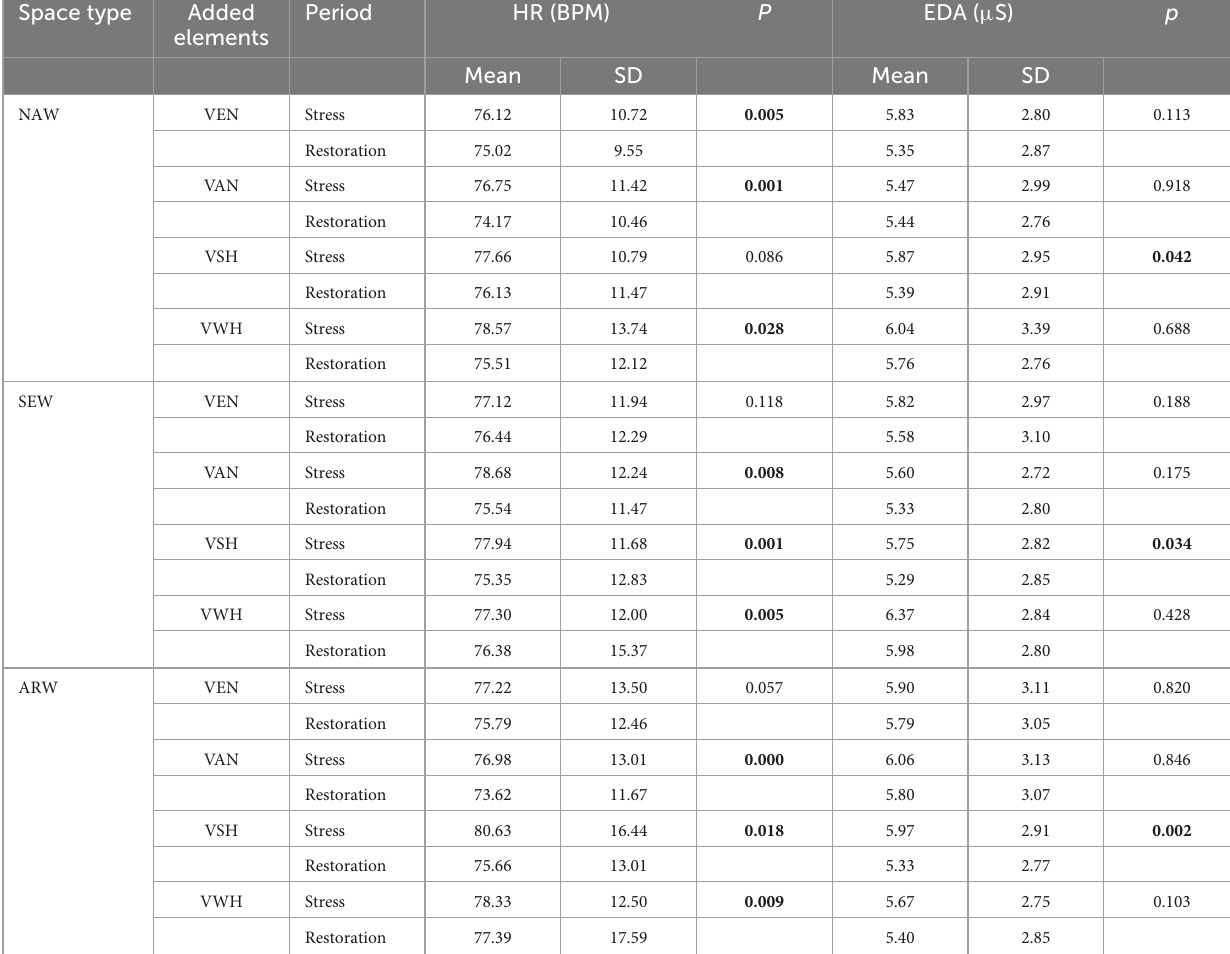
TABLE 4 Effects on subjects’ HR and EDA after adding different audio elements to NAW, SEW, and ARW. Space type